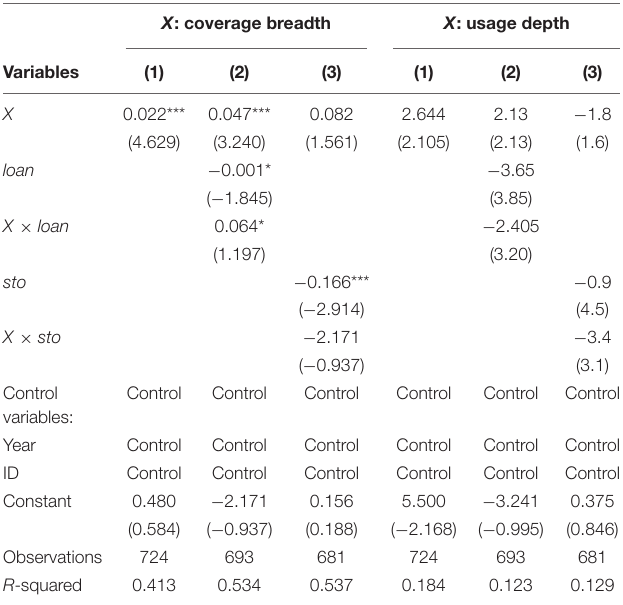
TABLE 4 | Coverage breadth and depth of use of digital financial inclusion and innovation